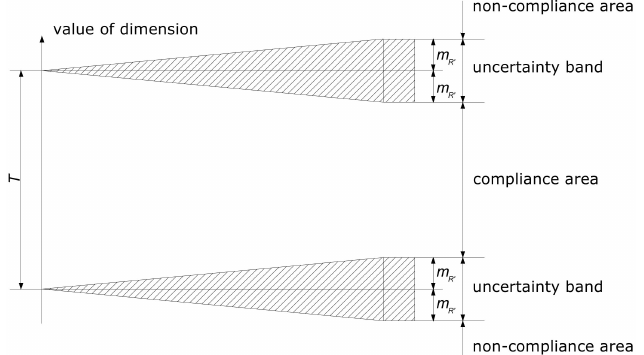
Figure 7. The impact of measurement inaccuracy on the appraisal of measured element dimensional quality. mR’—standard deviation occurring in the determination of dimension R, T—process tolerance, compliance area—tolerance area less the standard deviation occurring in the determination of dimension R, non-compliance area—area outside the tolerance area plus the standard deviation of measurements, uncertainty band—area where compliance cannot be